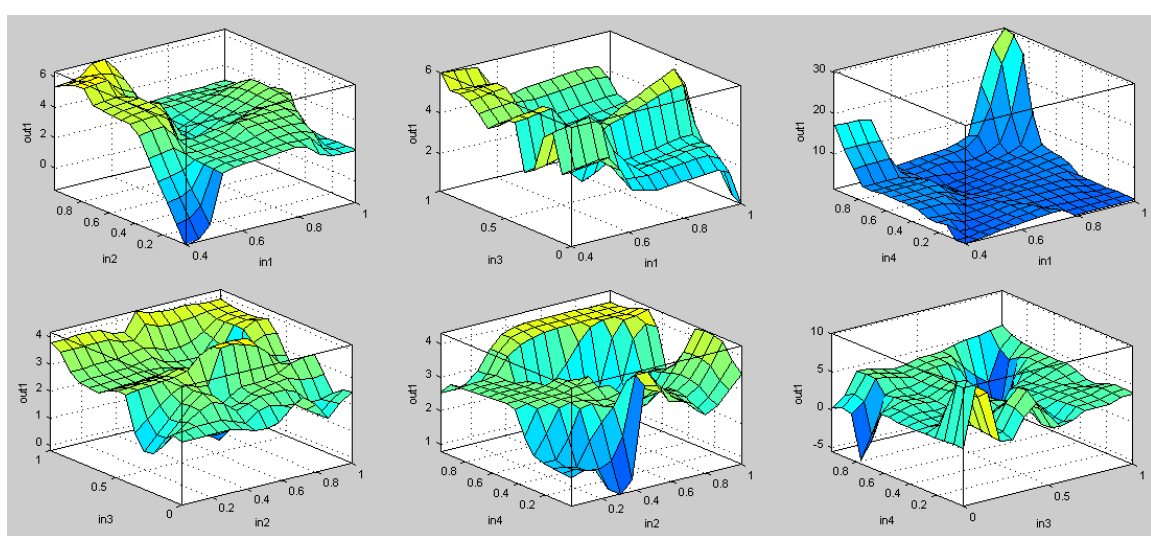
Figure 19. Surface comparison between the input values of the ANFIS.